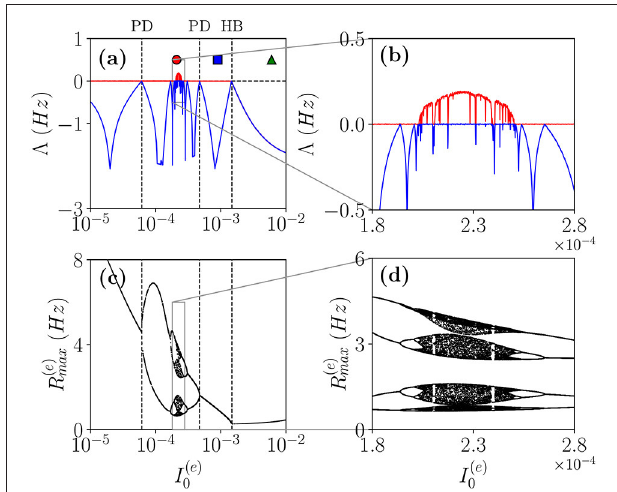
FIGURE 4 | Coherent chaos. (a,b) First (red) λ 1 and second λ 2 (blue) (LEs) for the MF vs. the DC current I ( e ) 0 for the parameter cut corresponding to the dashed black line in Figure 1A . The dashed vertical lines in (a) indicate a super-critical Hopf bifurcation (HB) from a stable focus to periodic COs and the region of the period doubling (PD) cascade. The symbols denote three different types of MF solutions: namely, stable focus (green triangle); periodic oscillations (blue square) and chaotic oscillations (red circle). (c,d) Bifurcation diagrams for the same region obtained by reporting the maximal value of the instantaneous firing rate R ( e ) measured from MF simulations. The parameters are the same as in Figure 1 , other parameters set as 1 ( ii ) 0 =